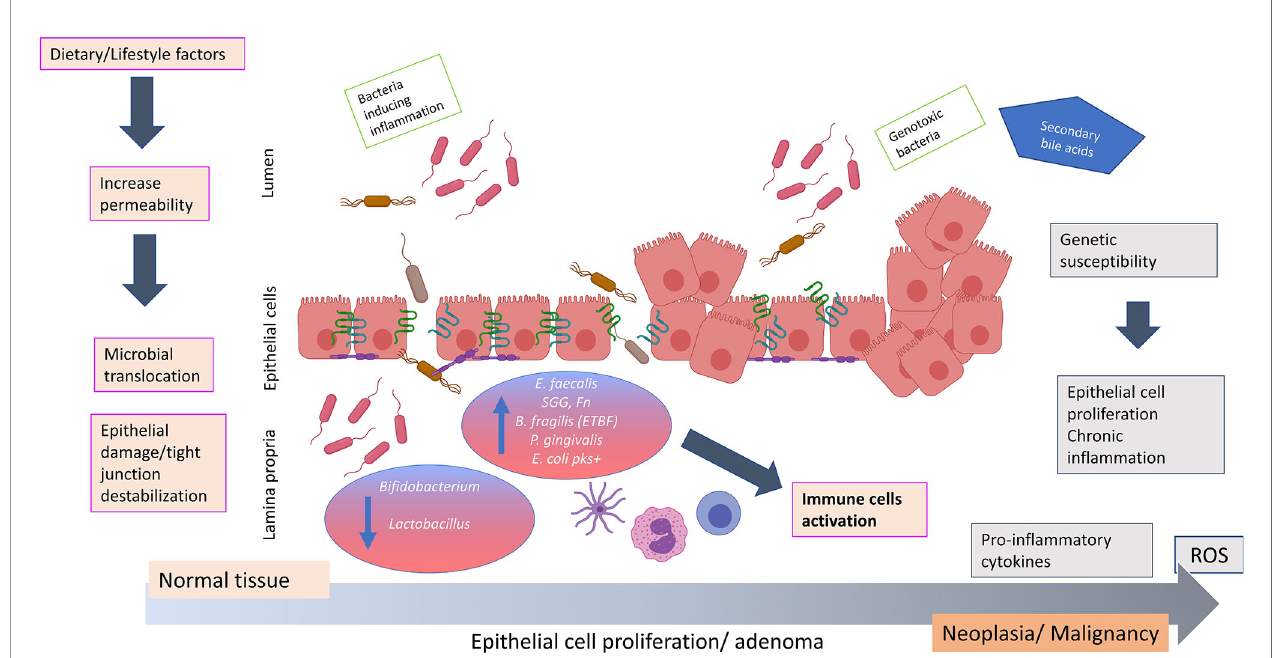
FIGURE 1 | Hypothesis of how bacterial translocation across a weakened colonic mucosal barrier may promote colorectal carcinogenesis. The impaired of barrier integrity aggravated by dietary/lifestyle factors contributes to an important shift in the microbiota composition. Commensal bacteria may acquire invasiveness properties and disturb the epithelial structure causing the passage of bacterial strains such as Fusobacterium nucleatum, Bacteriodes fragilis, Streptococcus gallolyticus subspecies gallolyticus, Porphyromonas gingivalis, Escherichia coli pks+ and Enterococcus faecalis . The invasiveness properties of these microbes due to virulence factors may impair the gut barrier integrity and cause epithelial damage and tight junction destablization. This aggravates bacterial translocation creating an environment favorable to disease promoting (potentially exacerbated in individuals of contributing genetic predisposition), resulting in the production of pro- in fl ammatory cytokines (IL3, IL10, IL6, TNF a ) and release of reactive oxygen species. These events may potentiate chronic in fl ammation, uncontrolled epithelial cell proliferation and colorectal neoplasia formation. ROS, reactive oxygen species; IL, interleukin; TNF, tumor necrosis factor; SCFA, short chain fatty acids; E. faecalis, Enterococcus faecalis; SGG, Streptococcus gallolyticus subspecies gallolyticus ; Fn, Fusobacterium nucleatum ; B. fragilis, Bacteriodes fragilis ; ETBF, enterotoxigenic toxin producing Bacteriodes fragilis ; P. gingivalis, Porphyromonas gingivalis ; E. coli pks+, Escherichia coli pks+. The fi gure was created using